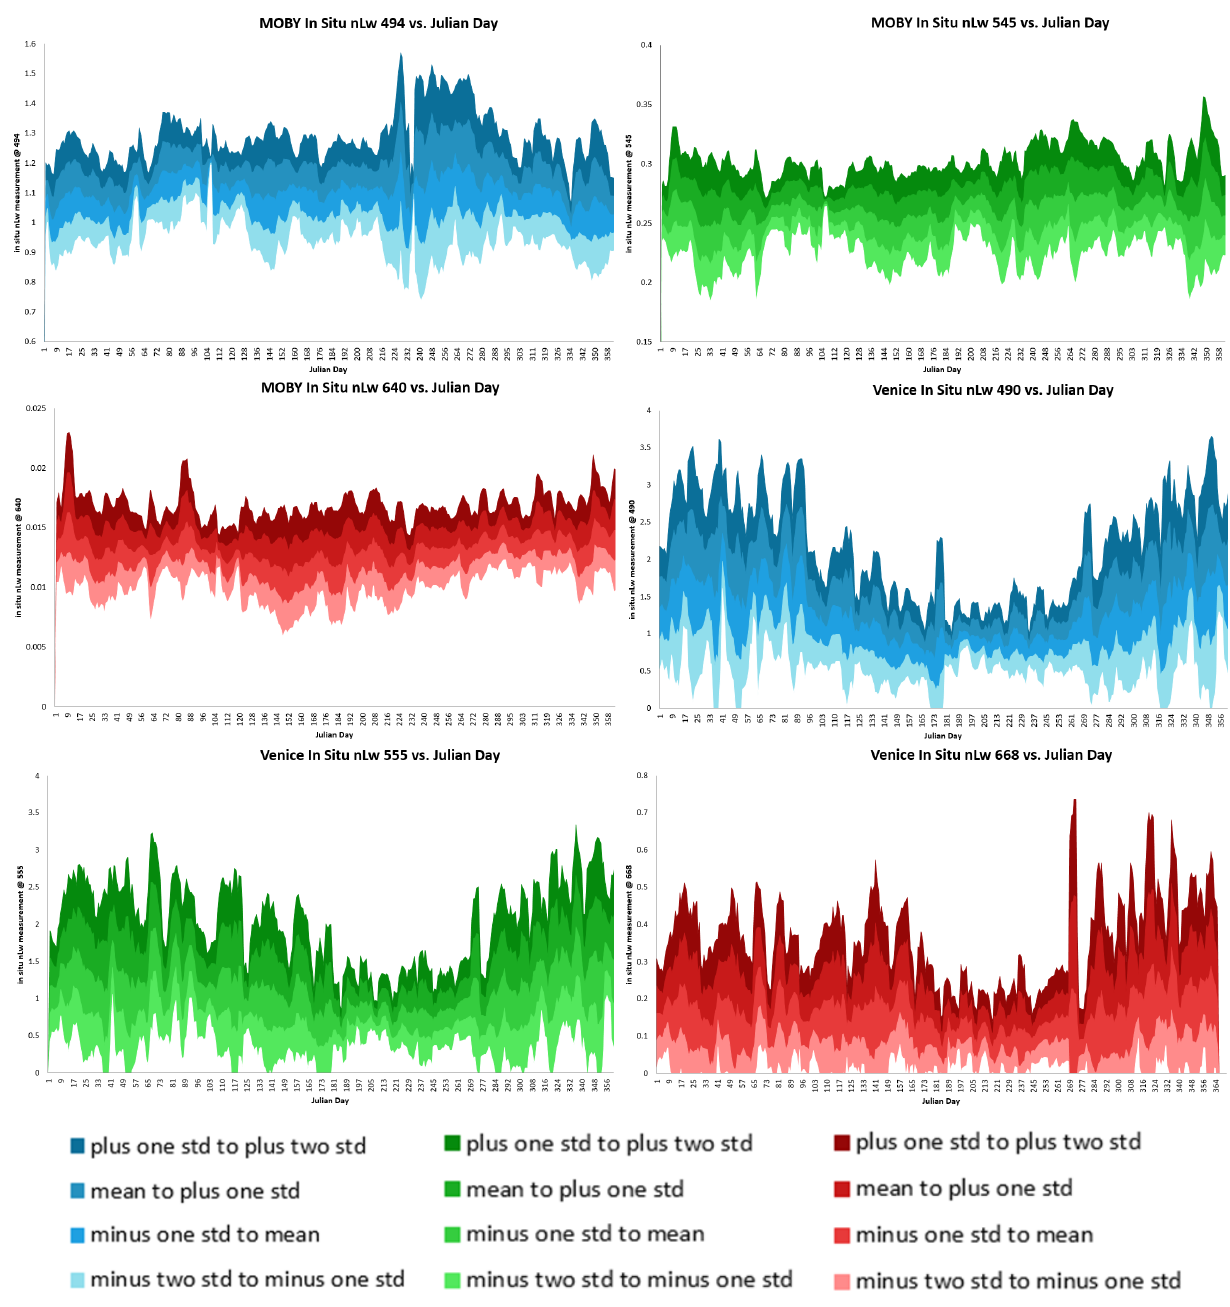
Figure 6. MOBY and Venice AERONET-OC in situ nLw climatologies. Top left : MOBY in situ nLw_494. Top right : MOBY in situ nLw_545. Middle left : MOBY in situ nLw_640. Middle right : Venice AERONET-OC in situ nLw_490. Bottom left : Venice AERONET-OC in situ nLw_555. Bottom right : Venice AERONET-OC in situ nLw_668.